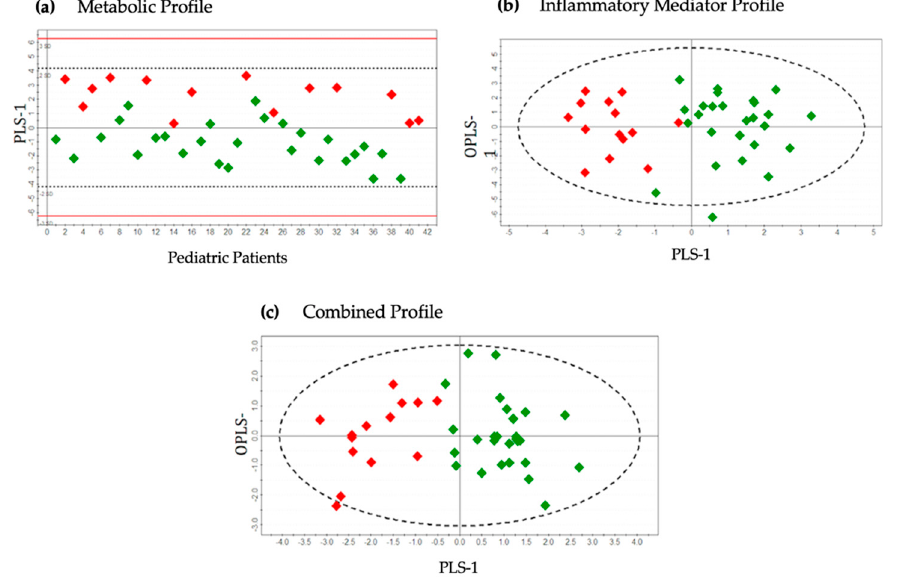
Figure 3. OPLS-DA score scatter plots distinguishing pediatric patients with severe and mild appendicitis using ( a ) metabolic profile (R 2 Y = 0.60, Q 2 = 0.48), ( b ) inflammatory mediator profile (R 2 Y = 0.63, Q 2 = 0.55), and ( c ) combined metabolic and inflammatory mediator profile (R 2 Y = 0.65, Q 2 = 0.57). Red diamonds represent distribution of pediatric patients with severe appendicitis, and green diamonds represent patients with mild appendicitis. OPLS—Orthogonal Partial Least Squares; PLS—Partial Least Squares. Table 2. Summary statistics from OPLS-DA models differentiating each pair of pediatric patient groups. Analysis